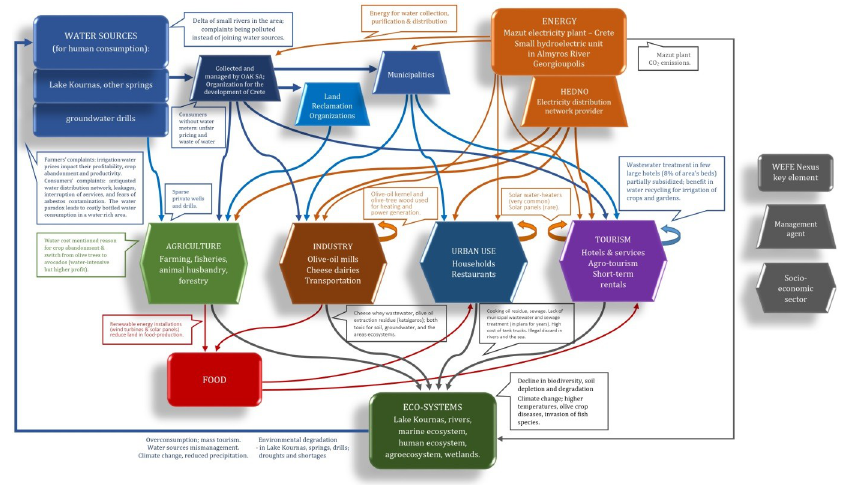
Fig 8. WEFE Nexus interconnections in